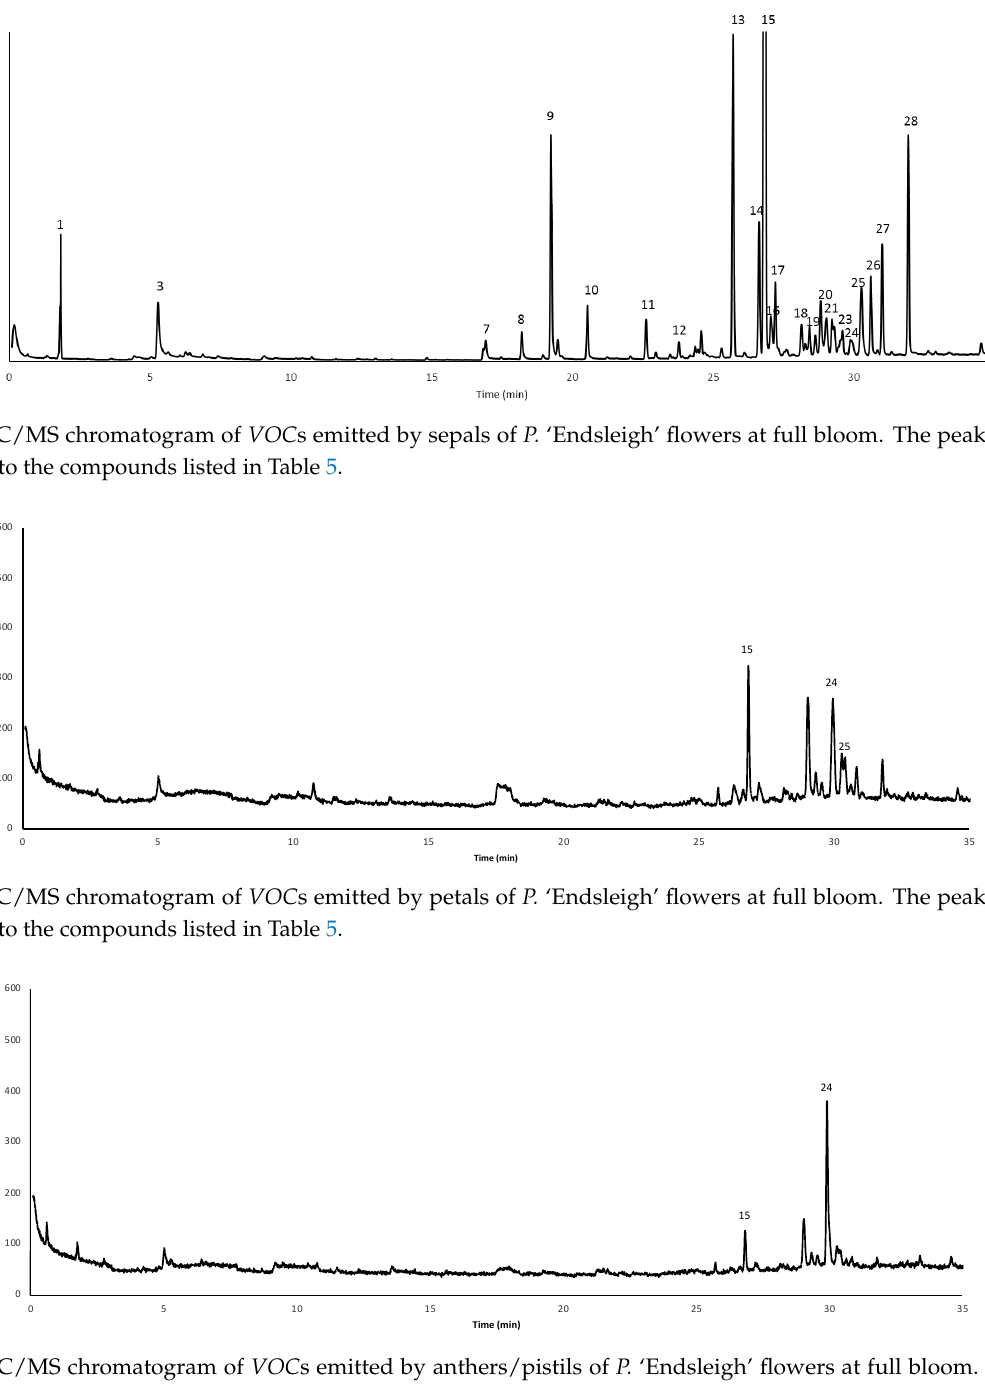
Figure 6. GC/MS chromatogram of VOC s emitted by anthers/pistils of P. ‘Endsleigh’ flowers at full bloom. The peak numbers correspond to the compounds listed in Table 5. Table 6. Volatile organic compounds produced by P. ‘Endsleigh’ sepals at full bloom and their semi- quantitative determination (ng/g FW).